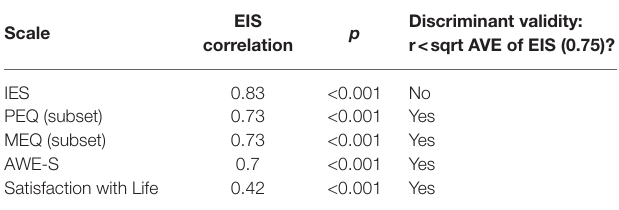
TABLE 13 | The experience integration scale.